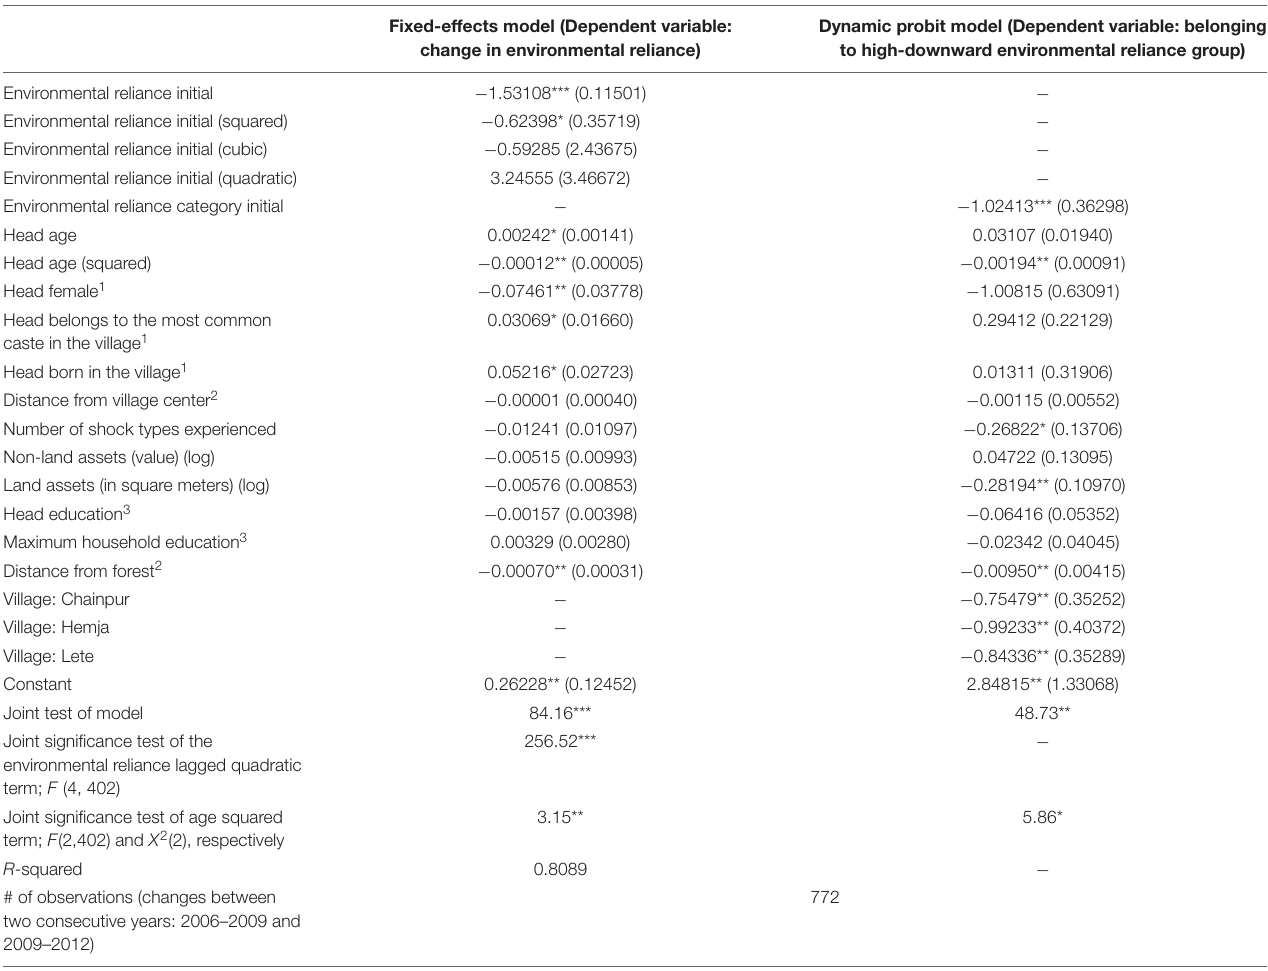
TABLE 4 | Fixed-effects and dynamic probit models results for households’ environmental reliance change and pathway, Nepal, 2006–2012; values in parenthesis are SEM. Fixed-effects model (Dependent variable: Dynamic probit model (Dependent variable: belonging change in environmental reliance) to high-downward environmental reliance